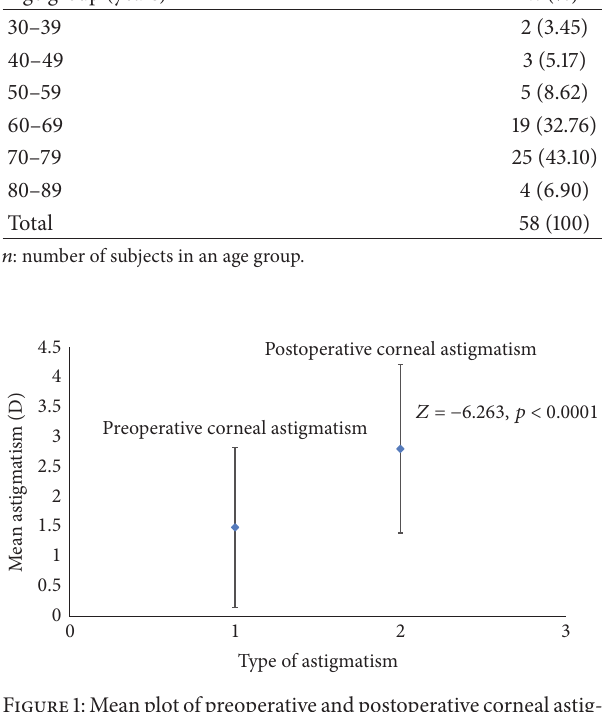
Figure 1: Mean plot of preoperative and postoperative corneal astig- matism with standard deviation error bars. A statistically significant difference is found between preoperative and postoperative corneal astigmatism ( 𝑝 < 0.0001